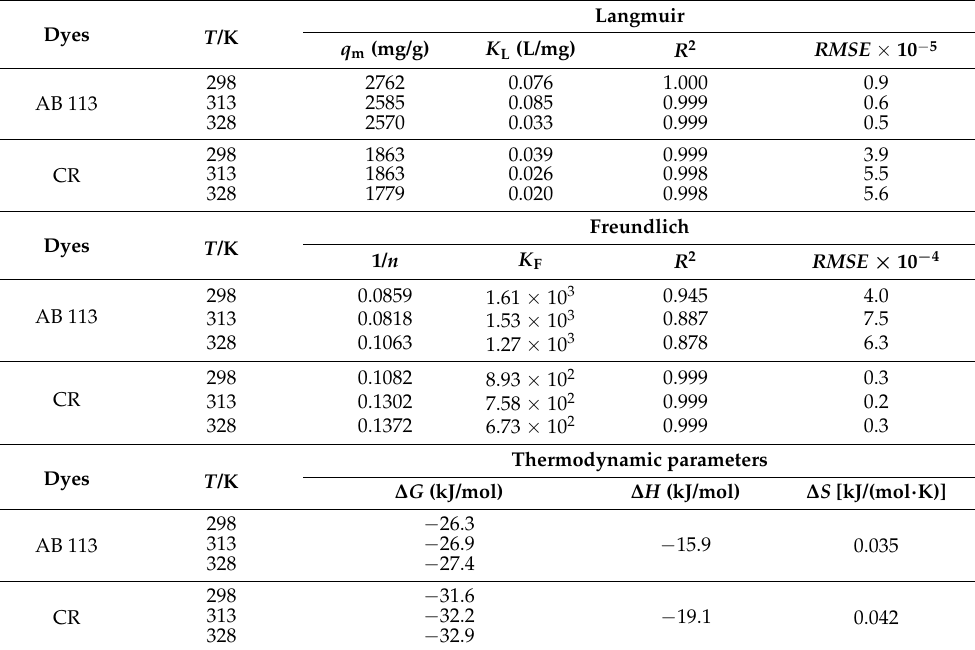
Table 2. Fitting results of two isotherm models for equilibrium data and thermodynamic parameters of dye adsorption onto the gel composite.